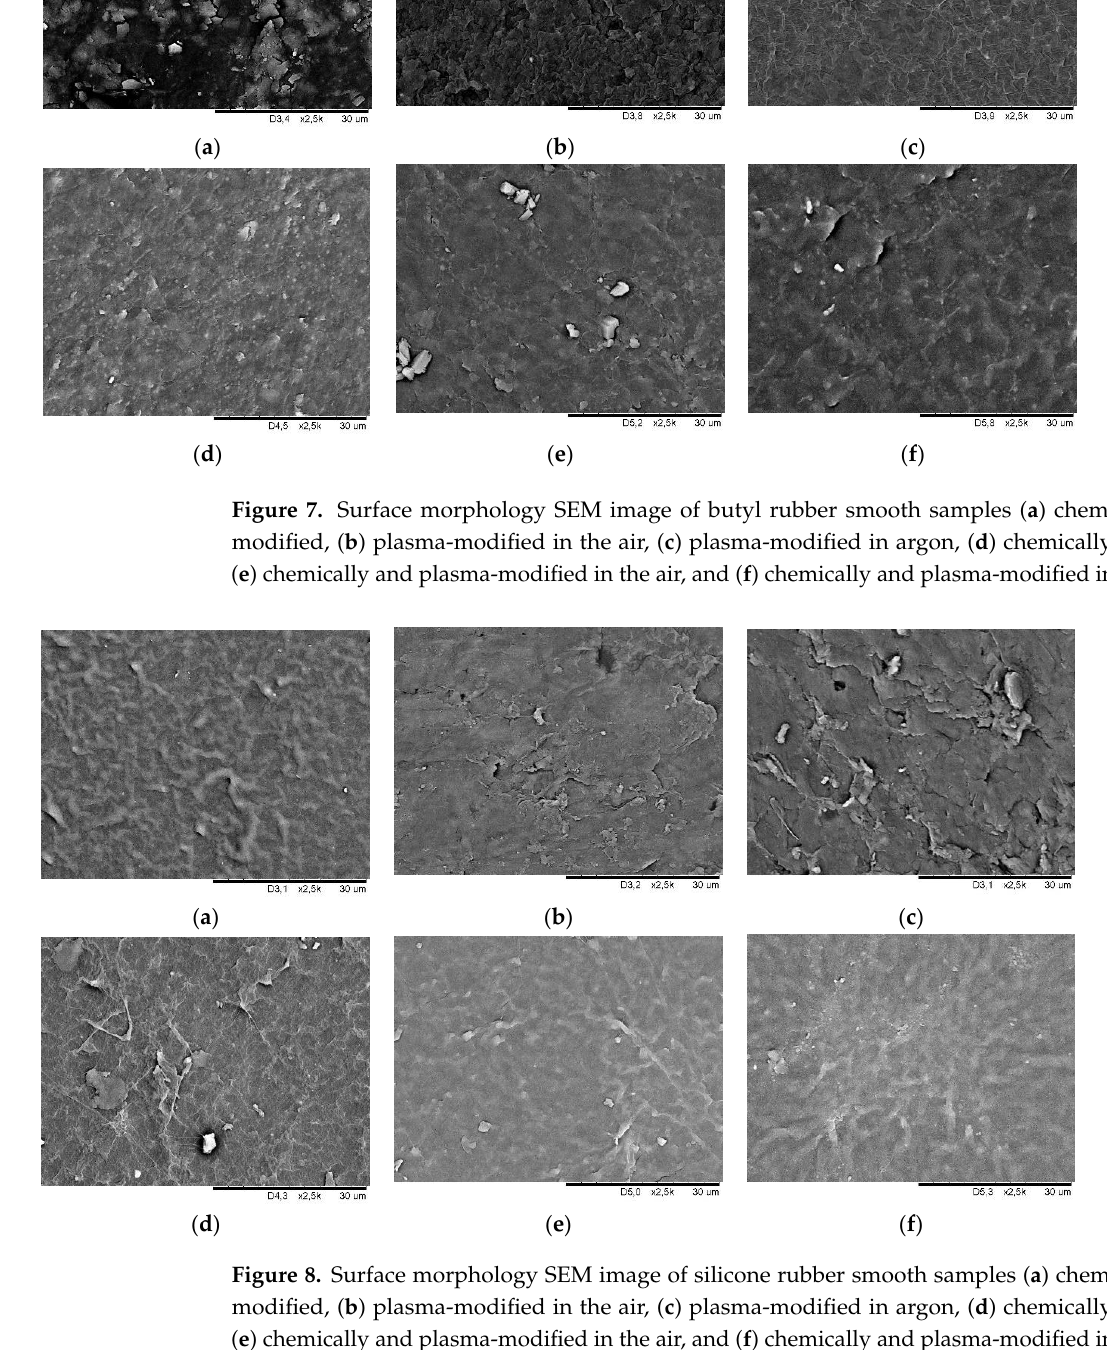
Figure 8. Surface morphology SEM image of silicone rubber smooth samples ( a ) chemically non- modified, ( b ) plasma-modified in the air, ( c ) plasma-modified in argon, ( d ) chemically modified, ( e ) chemically and plasma-modified in the air, and ( f ) chemically and plasma-modified in argon.